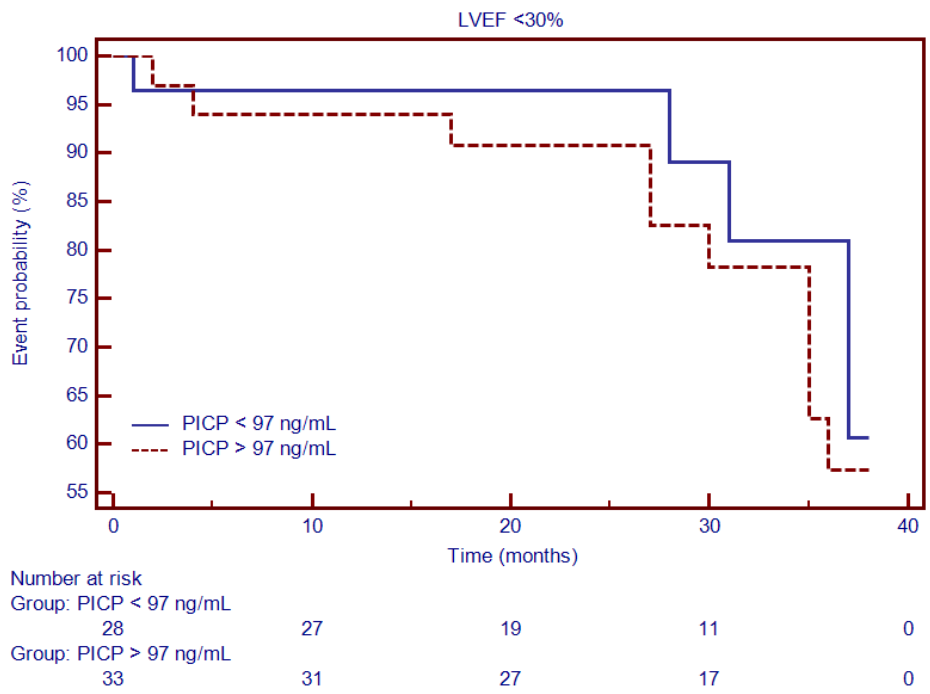
Figure 9. Kaplan–Meier analysis for the ability of PICP to predict cardiovascular outcome in patients with NIDCM and severely decreased LVEF <30%. Abbreviations: PICP, procollagen type I carboxy-terminal pro-peptide.